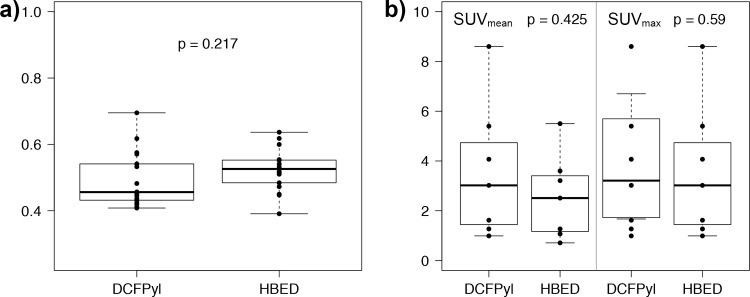
a) Average SUVs in unaffected bone tissue in 17 patients without bone metastases. b) SUVmean and SUVmax in a total of seven bone metastases in the group of patients with bone metastases.